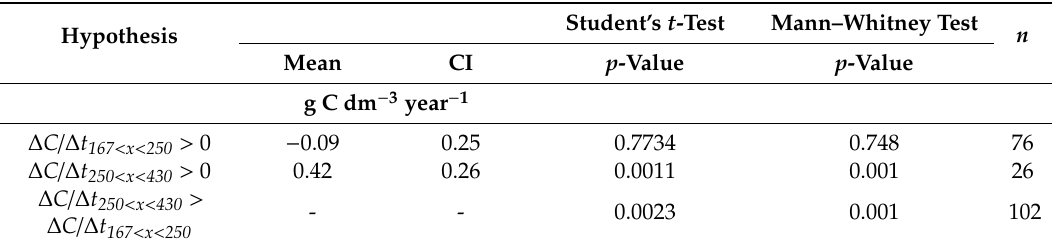
Table 3. Results of Student’s t -test and the Mann–Whitney test obtained for the ∆ C / ∆ t values of rainfed areas with di ff erent clay contents in the 0.00–0.20 m soil layer.